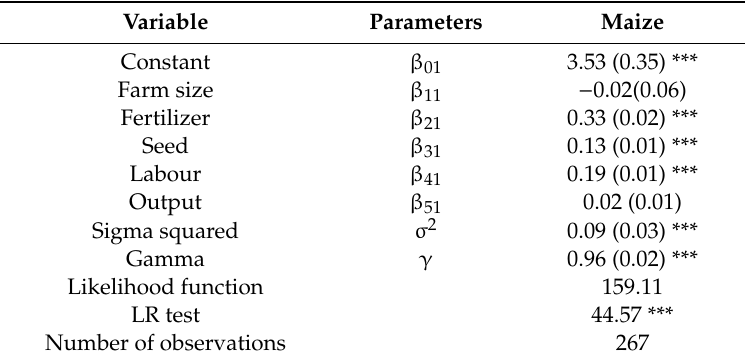
Table 5. Estimates of the Cobb–Douglas cost function for maize farms.